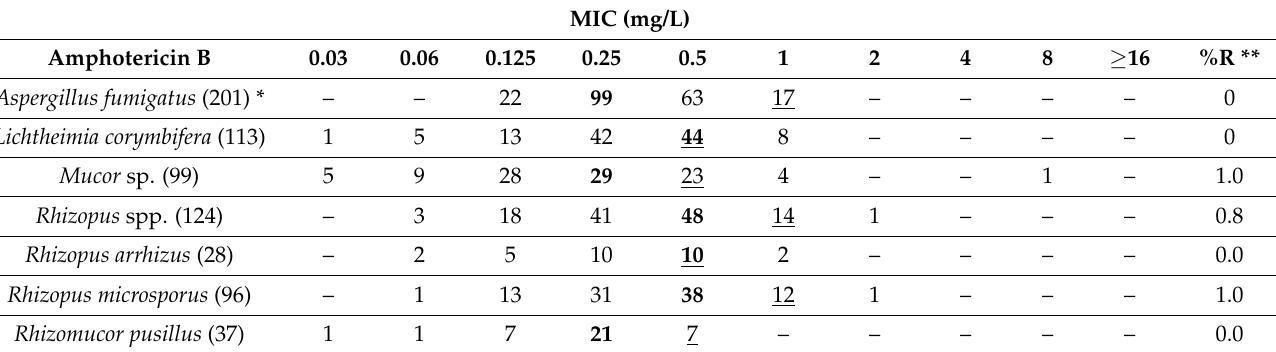
Table 2. MIC distributions for itraconazole. For presentation conventions, see Legend to Table 1. * Since a significant trend towards azole resistance in isolates of A. fumigatus referred to the MRL was observed over the study period, MIC values obtained with isolates of Aspergillus fumigatus for both the period 2019–2020 and also 2006–2016 are shown for comparison %R values greater than 30% are indicated in bold face.